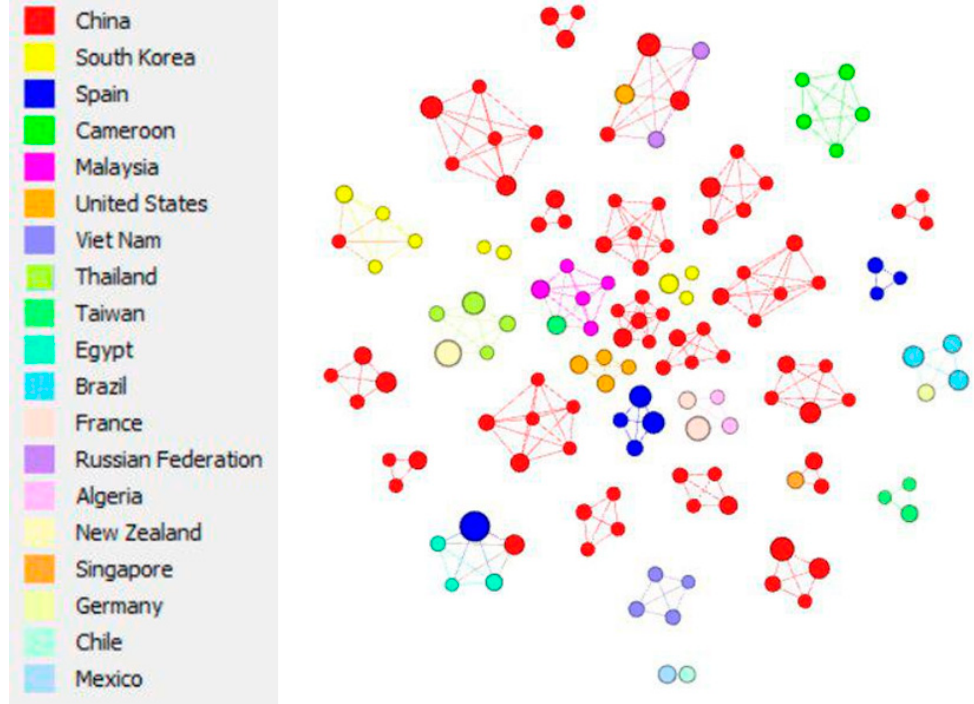
Figure 3. International interconnection between authors.